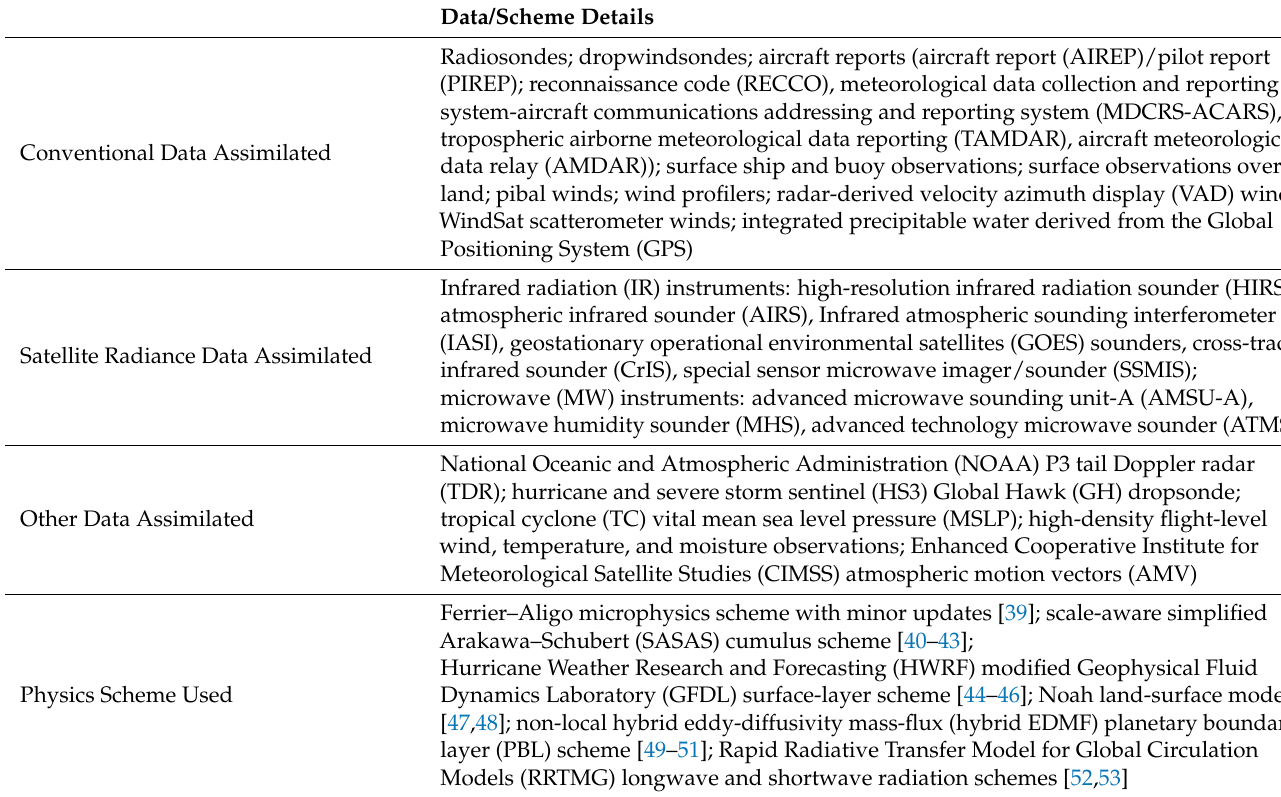
Table 1. List of observations assimilated and model physics